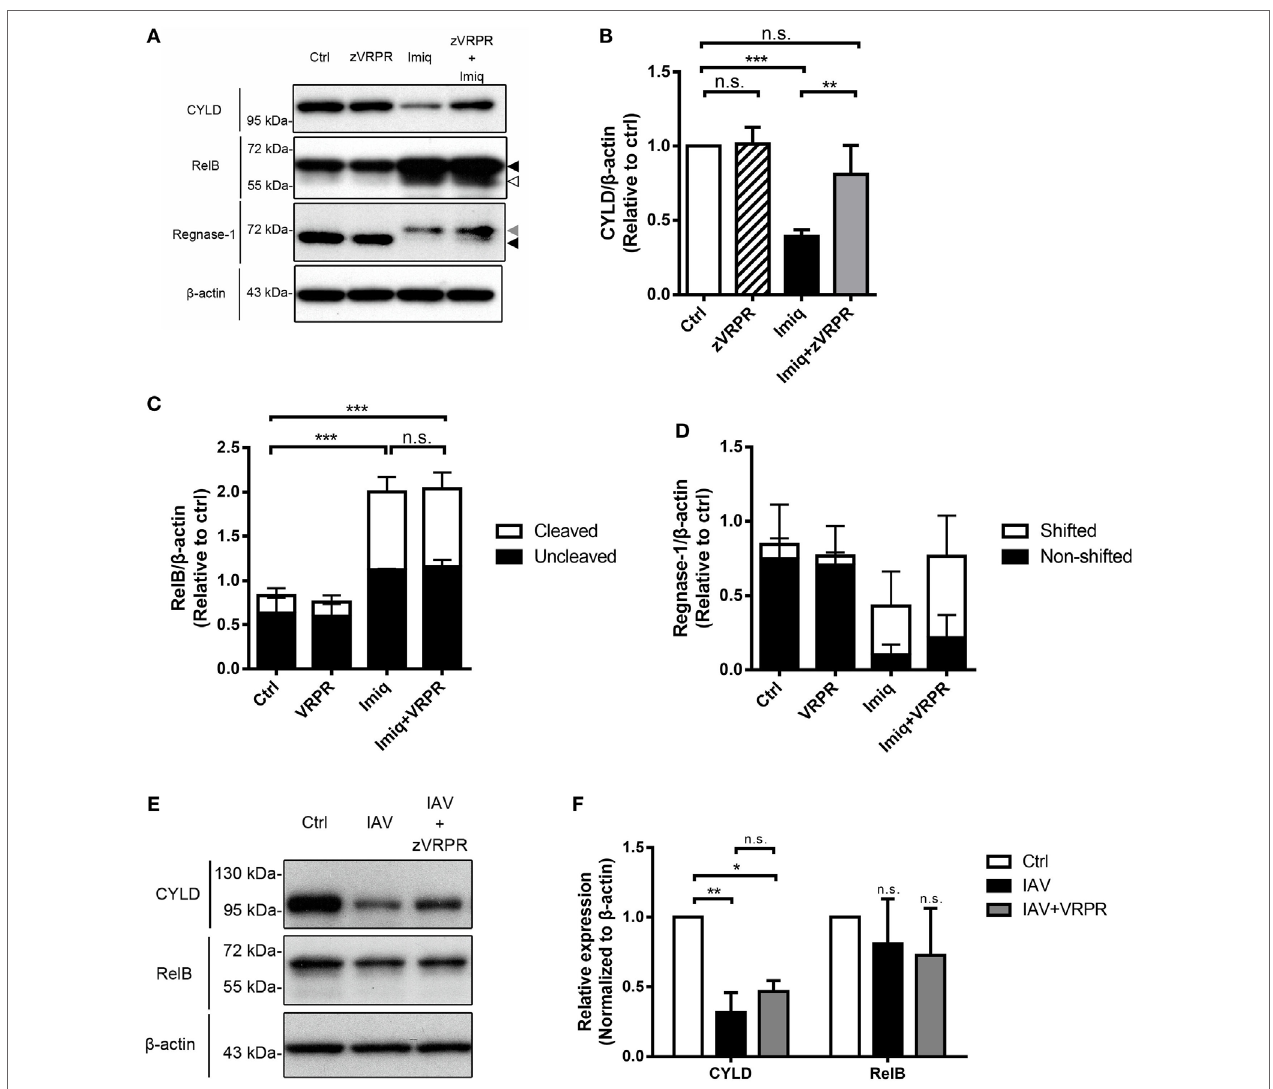
FigUre 5 | Toll-like receptor 7 signaling and IAV reduce the level of CYLD in alveolar macrophages. (a) MH-S cells were pretreated with or without z-VRPR-fmk (zVRPR, 100 µM) for 6 h before stimulation with or without imiquimod (Imiq, 1 µg/ml) for another 18 h. Cell lysates were analyzed by Western blotting with anti bodies against CYLD, RelB, and regnase-1. Bar graphs show the levels of (B) CYLD, (c) RelB, and (D) Regnase-1 protein normalized against β -actin ( n = 4, four independent experiments). Dark arrowhead points to total form of RelB or regnase-1, gray arrowhead to shifted band of regnase-1, empty arrowhead to cleavage form of RelB. (e) MH-S cells were pretreated with or without z-VRPR-fmk (zVRPR, 100 µM) for 6 h before stimulation with or without WSN virus (MOI = 0.25) for another 18 h. Cell lysates were analyzed by Western blotting with antibodies against CYLD and RelB. Bar graphs in (F) show the levels of CYLD and RelB protein normalized against β -actin ( n = 3, three independent experiments). One representative experiment is shown in (a,e) . (B–D,F) Relative intensity was calculated by dividing the intensity of indicated protein by β -actin and normalized against that of control (Ctrl). Data presented are the mean + SD; n.s., not significant; * p < 0.05, ** p < 0.01, and *** p < 0.001 compared to control (one-way ANOVA followed by Tukey’s post hoc